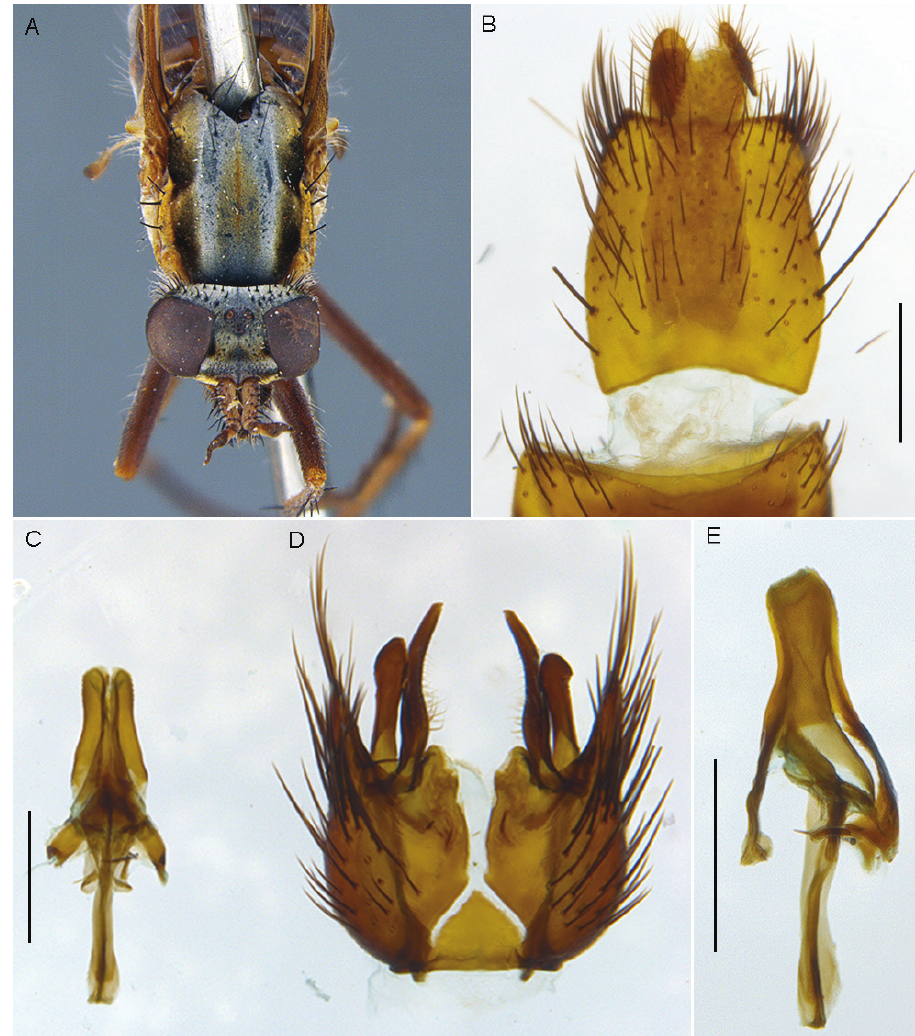
Figure 13. Sidarena hortorum sp. n.: A Female, head and thorax, dorsal view; male genitalia B Epan- drium and tergite 8, dorsal view C Aedeagus, dorsal view D Gonocoxites, ventral view (epandrium and aedeagus removed) E Aedeagus, lateral view. Scale line: 0.2 mm. pronotal lobe orange pubescent; scutellum yellow; pleuron dark-yellow orange pos- terodorsally, darker suffusion ventrally and anteriorly, covered with dense grey pu- bescence; pleuron with fine white pile on anepisternum and katatergite; chaetotaxy: np, 3; sa, 2; pa, 1; dc, 4; sc, 1; wing hyaline with dark tinge, especially anteriorly and along wing veins; venation dark; coxae dark with grey pubescence; legs dark yellow, femora with distinct brown suffusion; distal tarsomeres black. Abdomen . Dark yellow, extensive black-brown area medially on all tergites; silver velutum on tergites 1–5